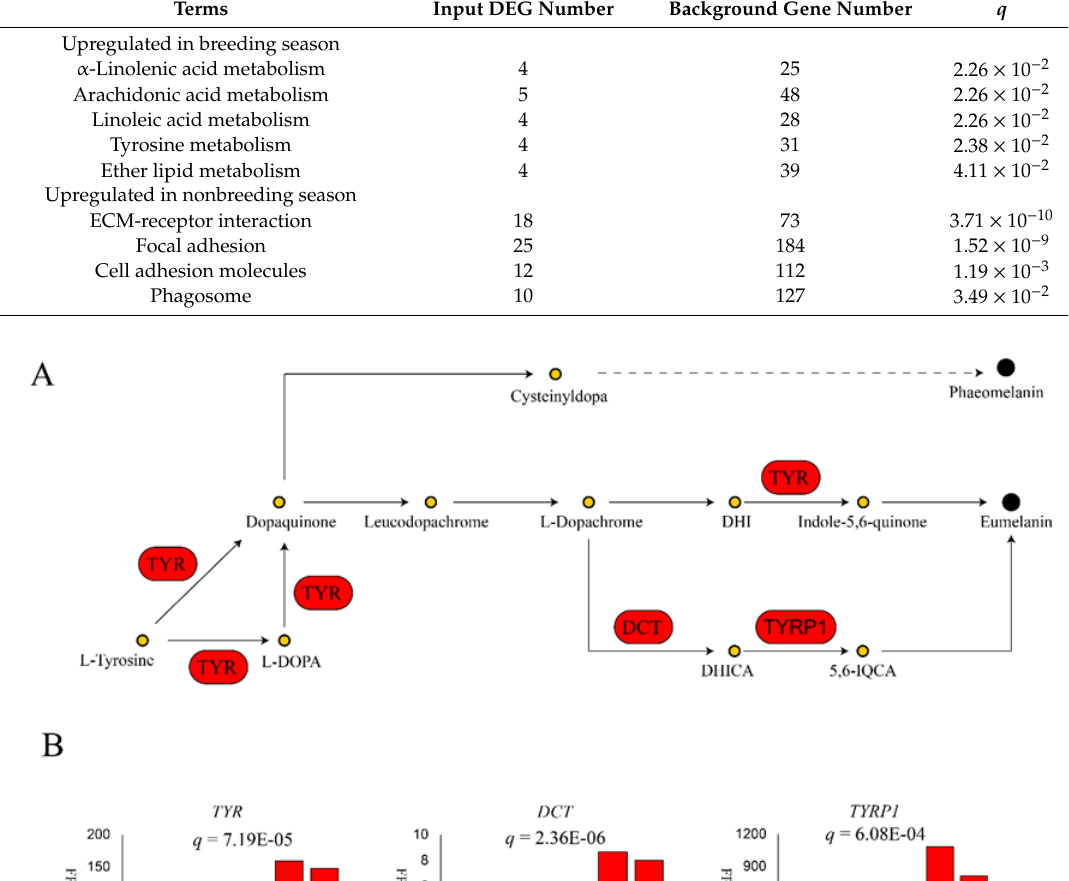
Table 3. Enriched KEGG pathways upregulated in black skins of the crested ibises in breeding and nonbreeding seasons.